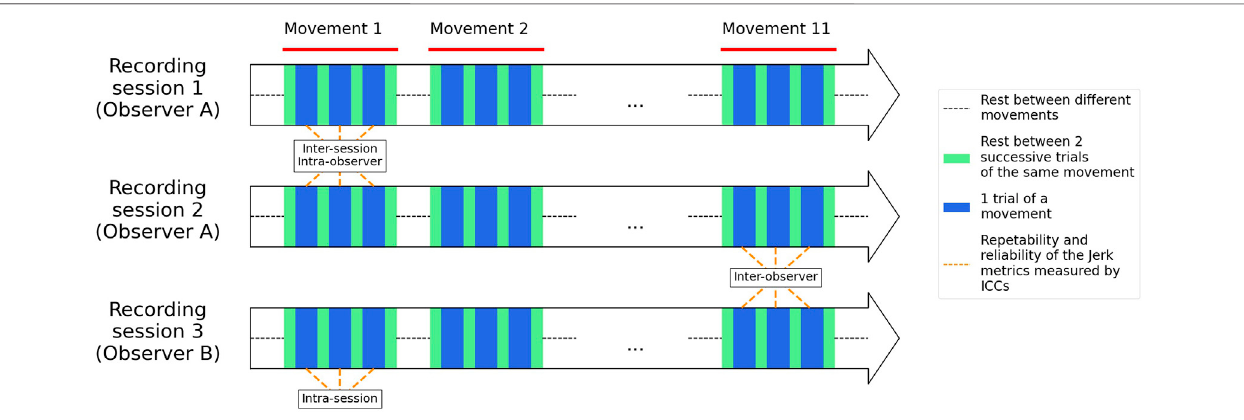
protocol containing 6 other arm movements. The whole protocol